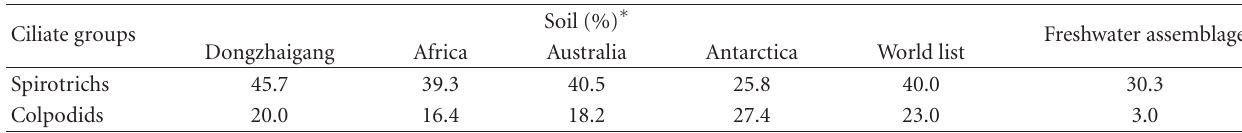
Table 7: Comparison (%) of the taxonomic composition of the faunas investigated with the world list of soil ciliates and a representative freshwater ciliates assemblage.